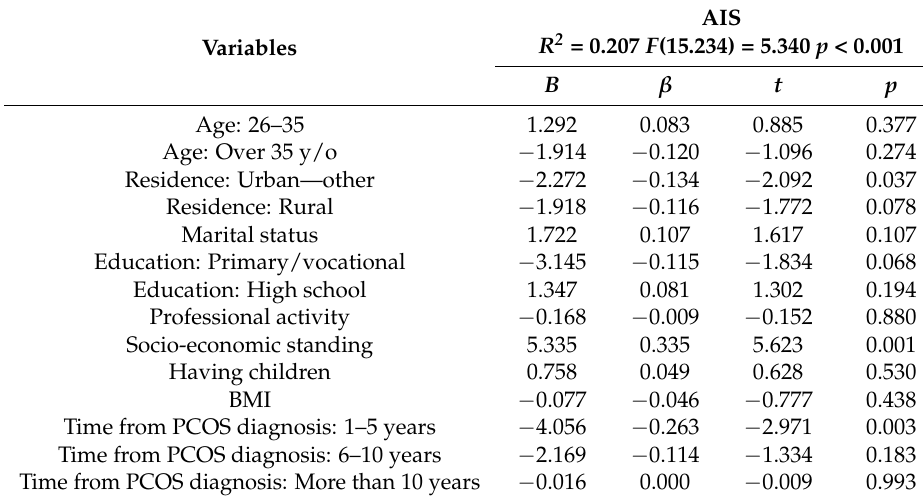
Table 5. Regression model for variables